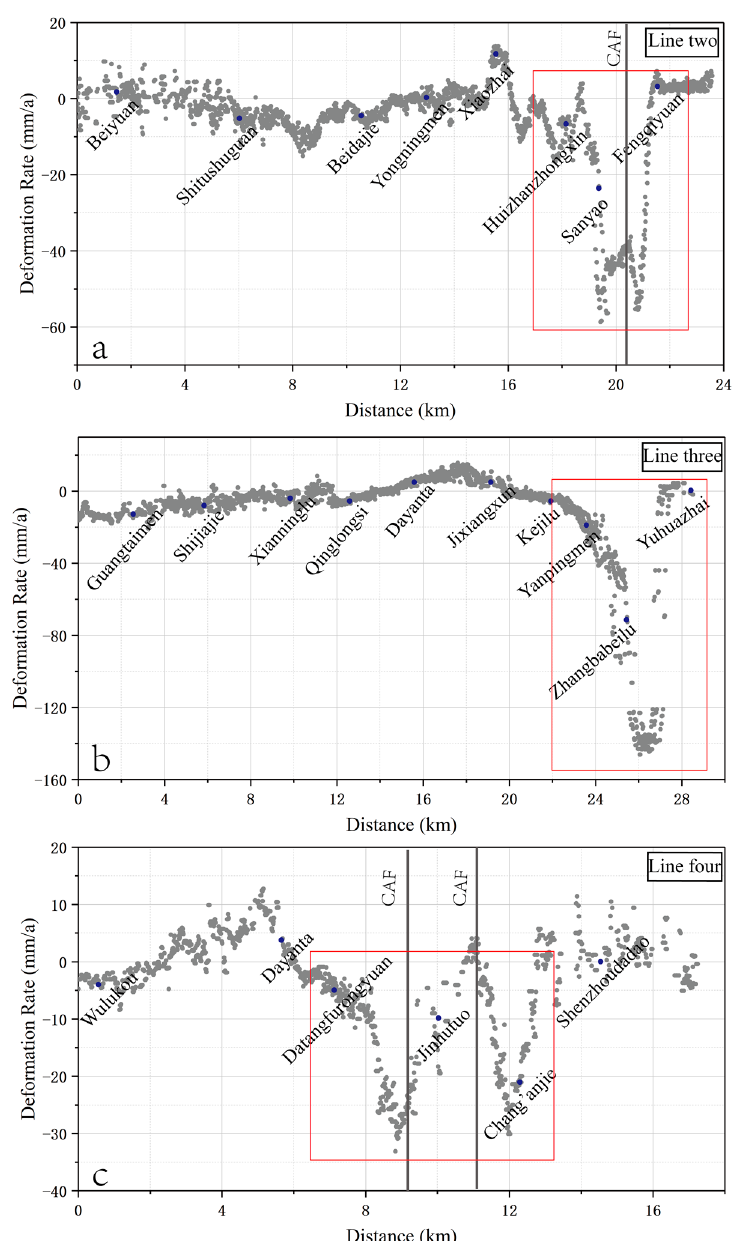
Figure 10. Deformation rate profile along subway line two ( a ), line three ( b ) and line four ( c ); the solid blue points denote the subway stations. The superimposed red rectangle boxes represent the maximum subsidence zone along the subway lines. The CAF is indicated by the grey line.